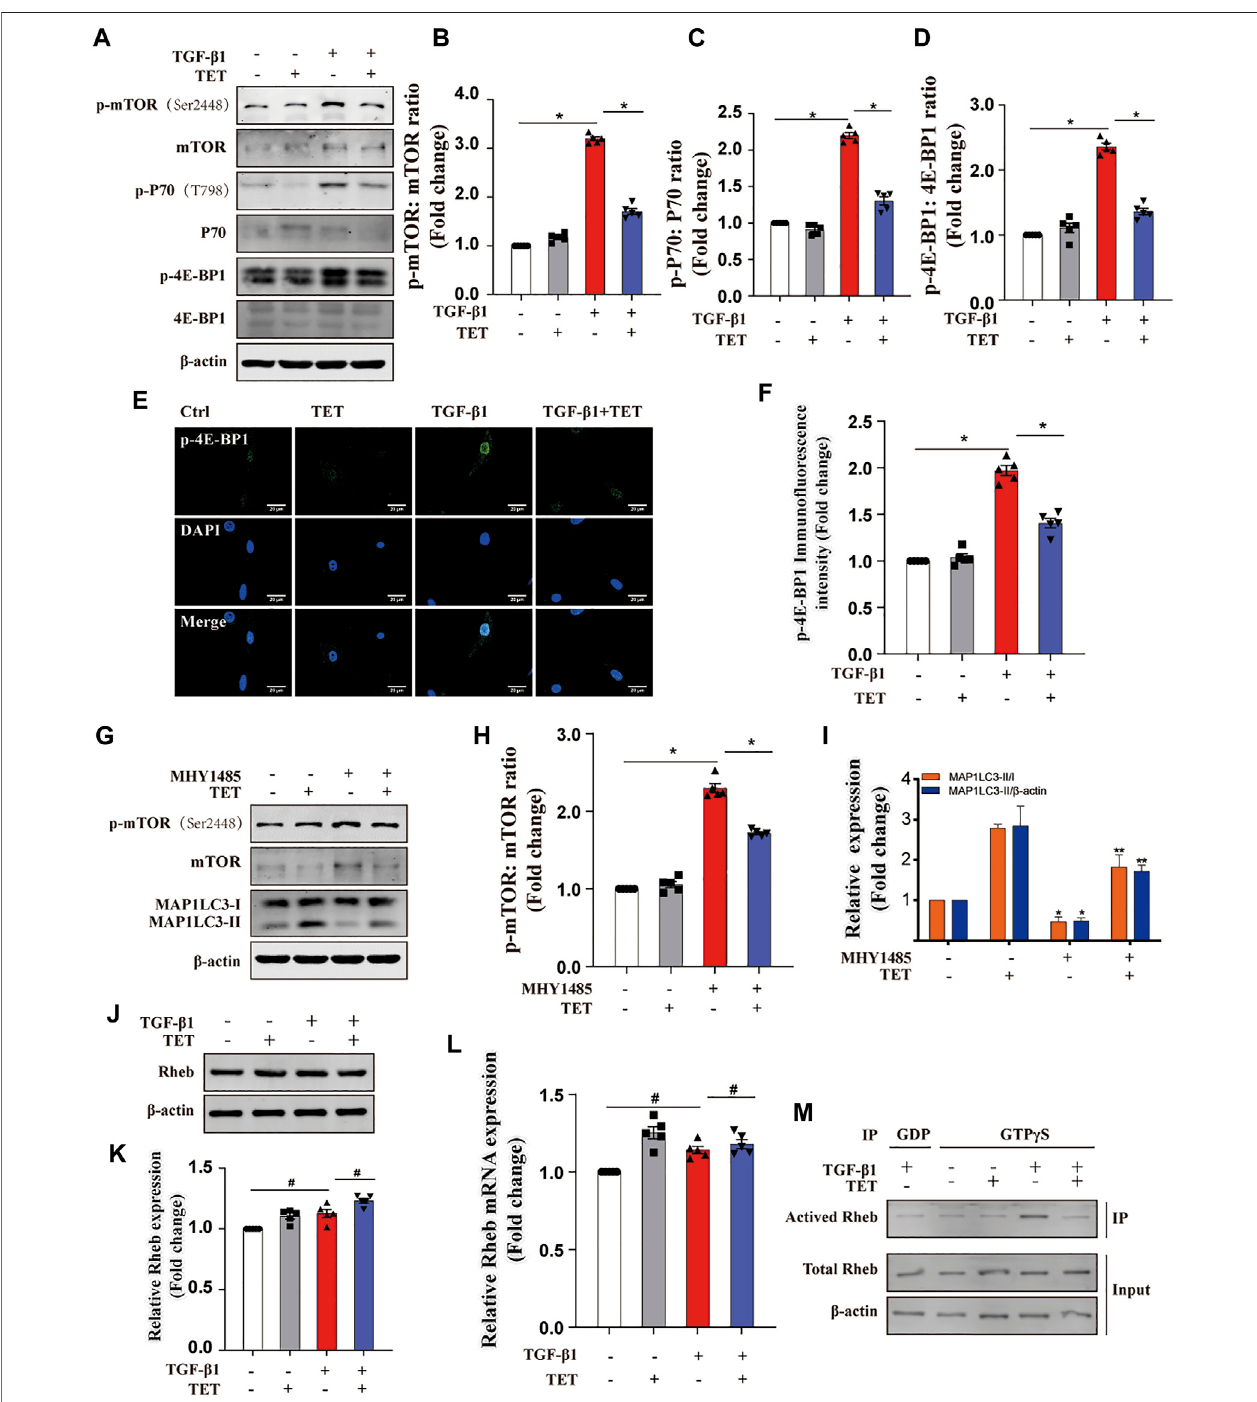
FIGURE 6 | TET activates autophagy by inhibiting Rheb/mTORC1 signaling. (A – D) Effect of TET on mTOR activation. Immunoblot (A) and quantitative analysis (B – D) showed the expression level of mTOR phosphorylation (p-mTOR), mTOR downstream substrates (p-P70, p-4E-BP1). (E,F) Representative images of immuno fl uorescencemonitoredbyconfocalmicroscopy (J) andquantitativeanalysis (K) showedtheexpressionofp-4E-BP1.Greenstainingisp-4E-BP1,bluestaining indicates nuclei. Scale bars: 20 μ m. (G – I) Effect of mTOR activation on autophagy regulation. Primary MLFs were cotreated with TET (4 μ M) and MHY1485 (5 μ M) for 24 h. Immunoblot (G) and quantitative analysis (H – I) showed the expression of autophagy markers (MAP1LC3-I/II, SQSTM1), mTOR activation (mTOR, p-mTOR). (J,K) Effect of TET on the expression of Rheb protein. Representative immunoblot analysis (J) and quantitative analysis (K) show the expression of Rheb protein. (L) Representative of qPCR analysis showed the mRNA expression of Rheb. (M) Effect of TET on Rheb activation. Co-immunoprecipitation was performed using agarose beads conjugated to an antibody directed against the GTP γ S and GDP. Immunoblot analysis was performed to check for protein expression of activated Rheb (Rheb/ GTP), total Rheb. Total Rheb includes the inactive GDP-Bound form (GDP) and activated Rheb (Rheb/GTP). Values in bar graph are presented as means ± SEM (n (cid:2) 5). Two-way ANOVA with Tukey ’ s multiple comparison test (n (cid:2) 5). * p < 0.05.